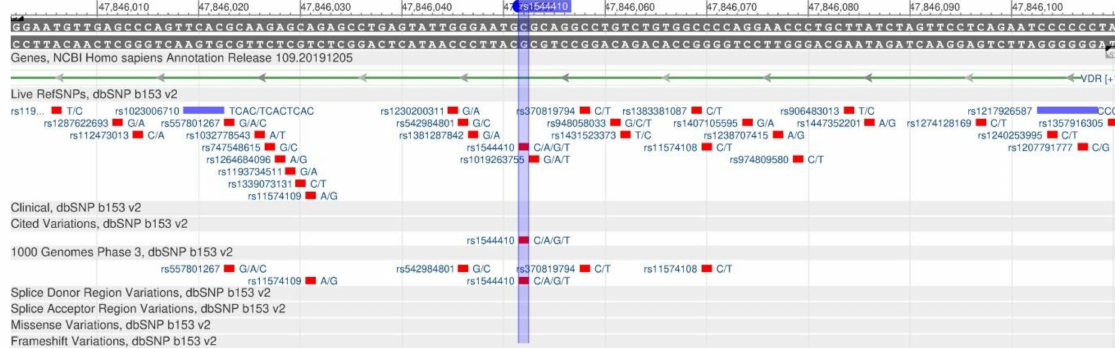
Figure 22. A section of the VDR gene (located on the long (q) arm of chromosome 12) containing the oligonucleotide polymorphism rs1544410.